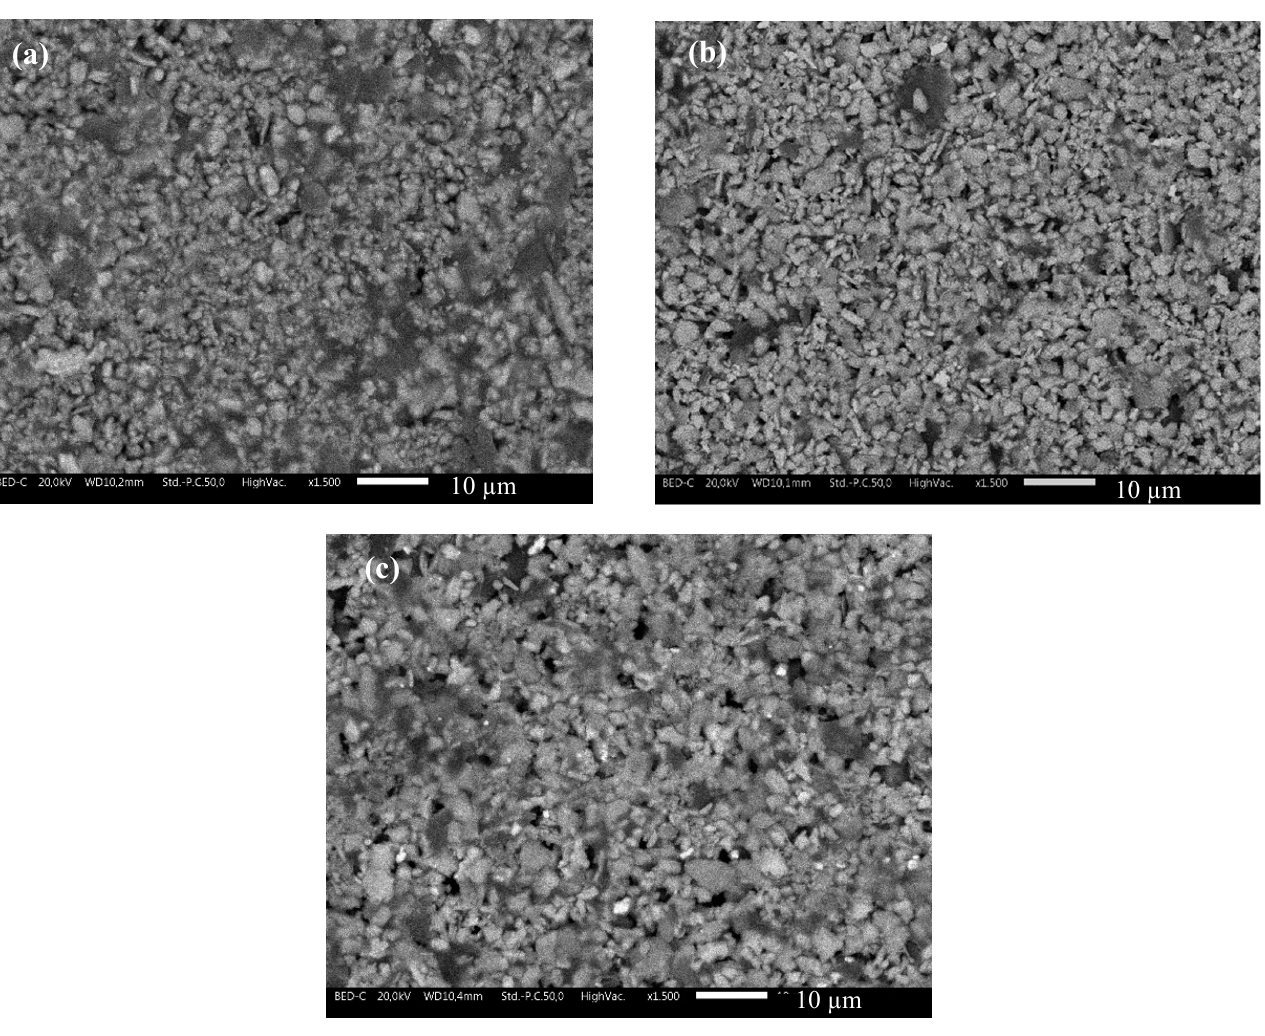
Figure 10. SEM images of the PM in the range of 10–2.5 µ m for the ( a ) uncoated martensitic stainless steel, ( b ) the WC-CoCr coating, and ( c ) the WC-FeCrAlY coating.